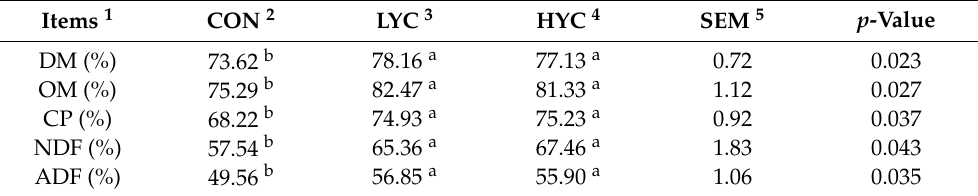
Table 3. Effect of dietary supplementation of YC on nutrient apparent digestibility of fattening Hu sheep.